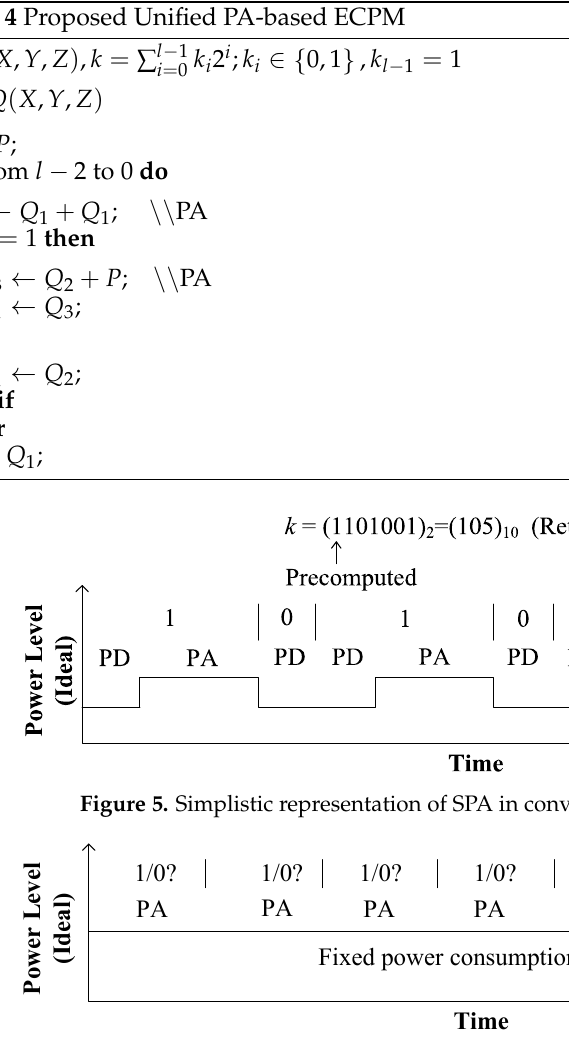
Figure 6. Simplistic representation of SPA in proposed unified PA-based ECPM.